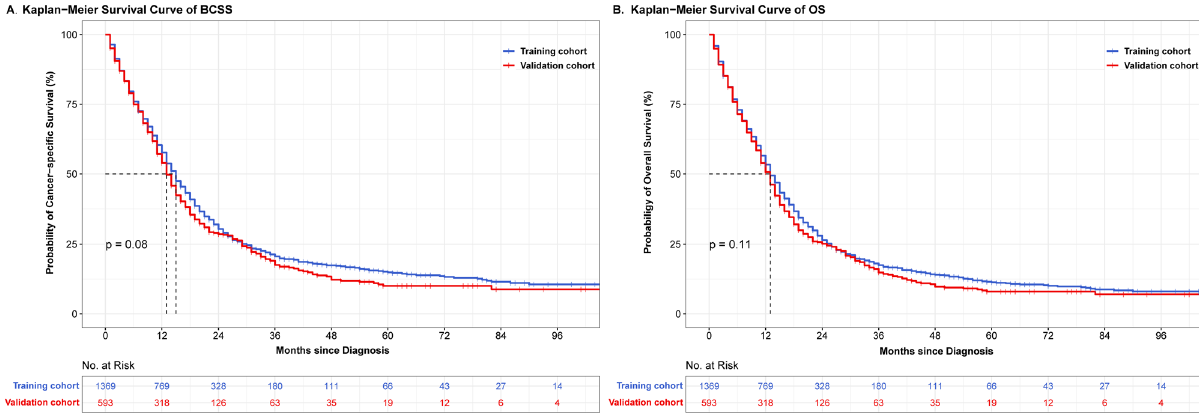
Figure 2. Survival curves of BCSS ( A ) and OS ( B ) in training and validation